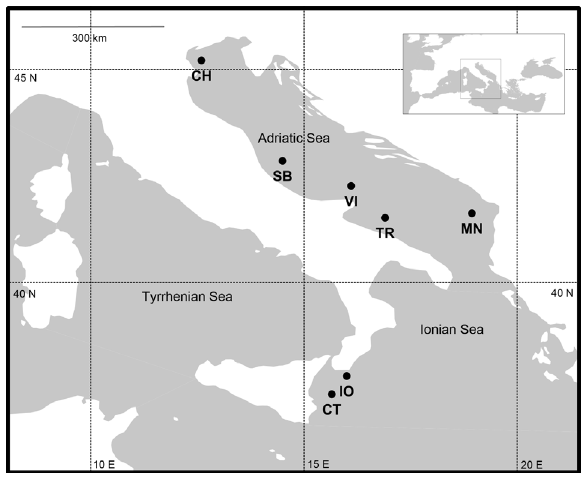
Fig. 1. – Map of sampling locations. Abbreviations as in Table 1.